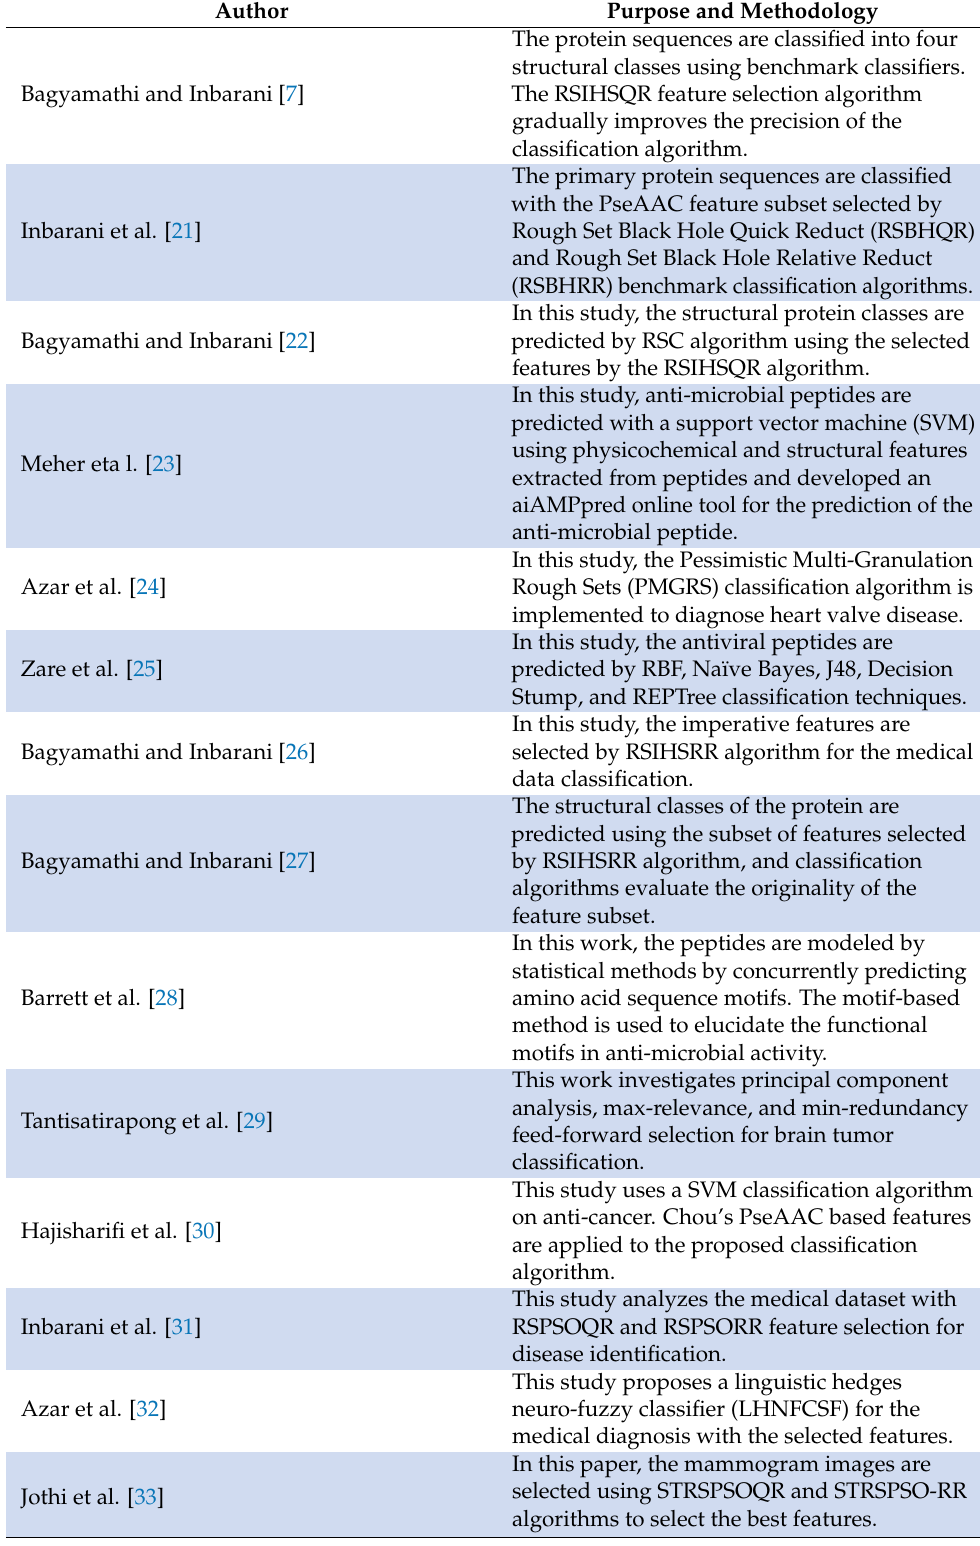
Table 1. Cont. Related work of this